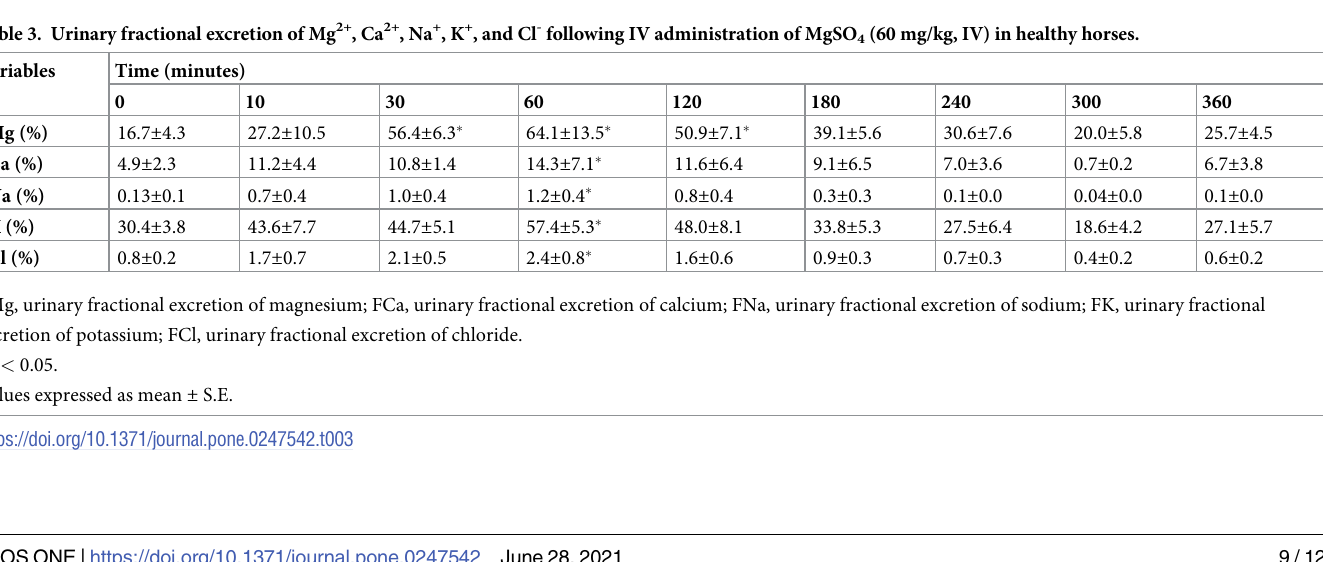
Fig 2. FMg and FCa (A) and FNa, FK and FCl (B) (%) following IV administration of MgSO 4 (60 mg/kg) in healthy horses. Values expressed as mean with S.E. � indicates statistically different than time 0 (P < 0.05). Rectangle over X axis represents IV administration of MgSO 4 over 5 minutes. FMg,